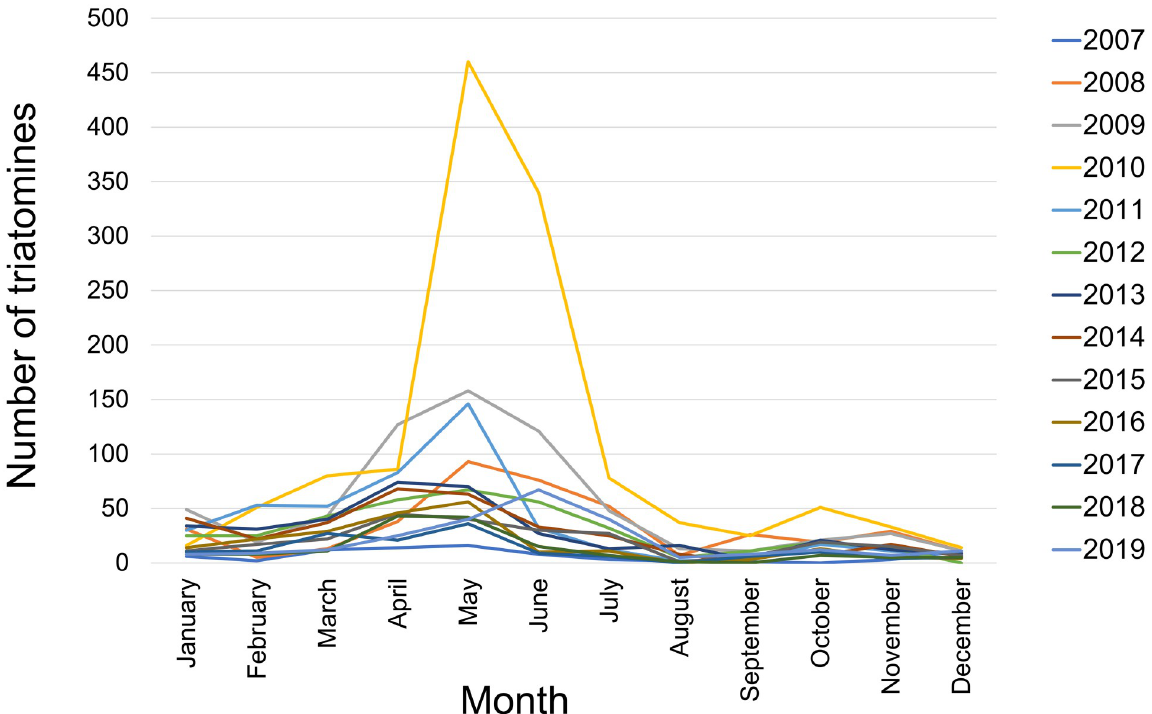
Fig 2. Monthly triatomine yield for the MDC collection period 2007–2019. Line color indicates collection year. Media attention to an oral Chagas disease outbreak in May 2010 may help explain the high collection numbers of May and June